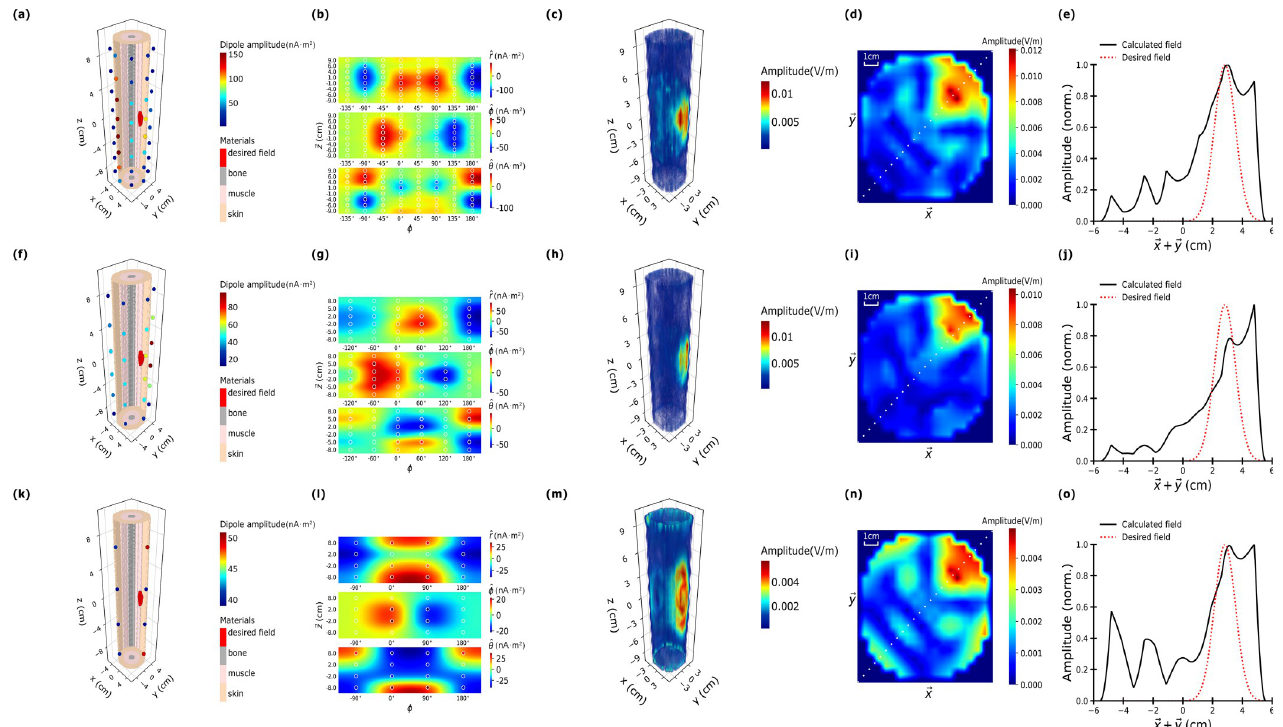
Fig 7. Cylindrical leg model with radius 5 cm and length 20 cm using (a), (d), (g) 64 dipoles, (b), (e), (h) 32 dipoles, and (c), (f), (i) 16 magnetic dipoles at 1 GHz. The leg model consists of cylindrical bone region 1 cm radius at the center, membranous muscle region 2 cm thickness, and membranous tissue 2 cm thickness. The format is the same as that of Fig